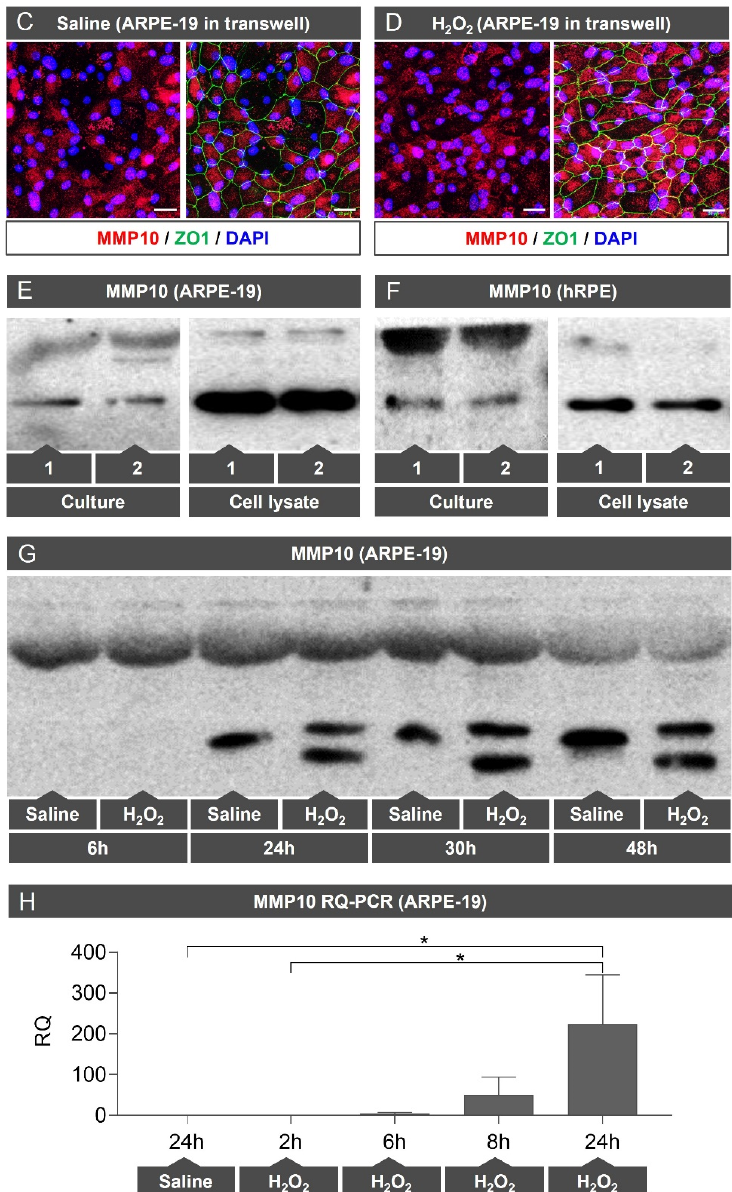
Figure 2. MMP10 is expressed in ARPE-19 cells and overexpressed under oxidative stress conditions. ( A ) Control ARPE-19 cells expressing MMP10 (red) and cytokeratin 18 (CK18) (green) in coverslips. ( B ) ARPE-19 cells exposed to H 2 O 2 at 800 µ M during 48 h showed a prominent increase in MMP10 ex- pression (red) in coverslips. DAPI (blue) label nuclei. ( C ) ARPE-19 cells in transwell inserts in saline medium. ( D ) ARPE-19 cells in transwell inserts exposed to H 2 O 2 at 800 µ M during 48 h showed a prominent increase in MMP10 expression (red). ( E , F ) WB analysis of MMP10 under basal conditions in the supernatant and cell lysate of ARPE-19 ( E ) and hRPE ( F ) cells. As can be observed, both cell lines have a marked expression of MMP10 contained intracellularly and present a measurable concen- tration of extracellular MMP10. No proteolytic activation of MMP10 is observed in basal conditions, neither intra- nor extracellularly. ( G ) WB analysis of MMP10 in supernatant of ARPE-19 cells in saline medium and exposed to H 2 O 2 at 800 µ M at different times (6, 24, 30 and 48 h). MMP10 is expressed under basal conditions over time and H 2 O 2 exposition seems to activate the protein generating two visible bands. ( H ) RT-PCR shows a significative increased in MMP10 mRNA transcription over time under oxidative stress conditions. Scale bar: 20 µ m. MMP10 = Matrix metalloproteinase 10. * p <